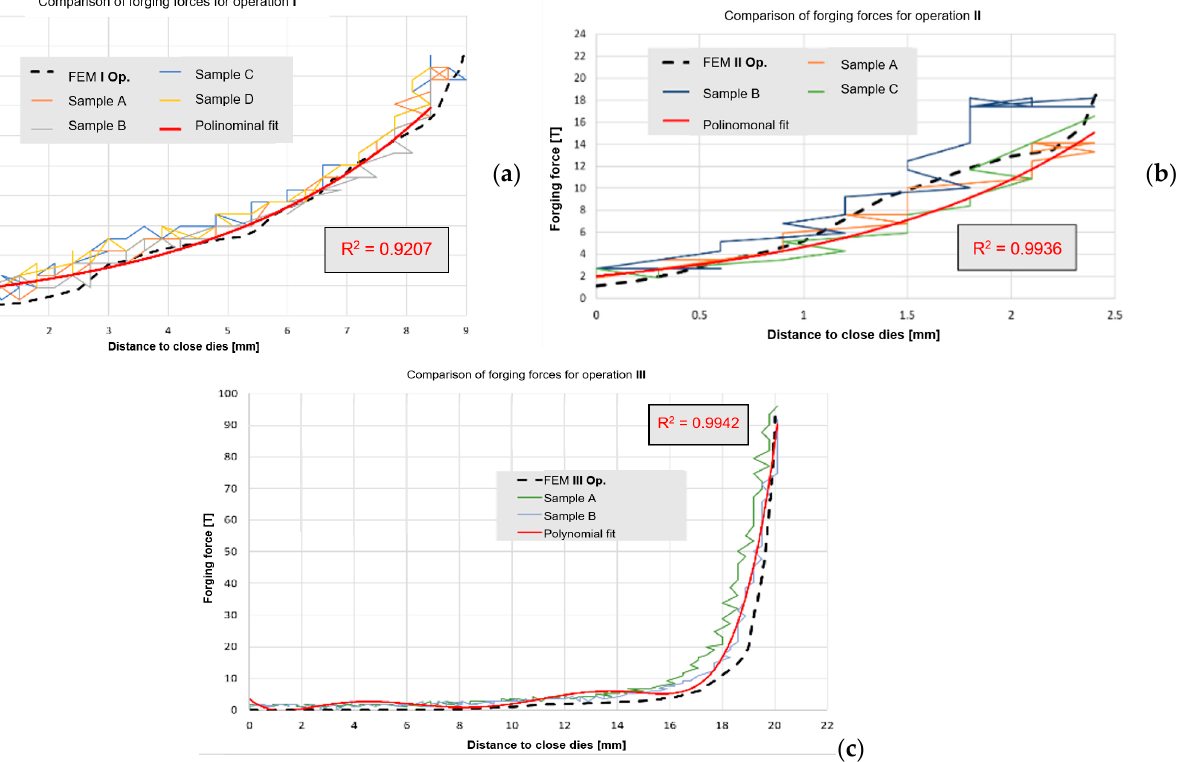
Figure 12. Comparison of the forging forces for each of the 3 operations of physical modeling with the FEM results: ( a ) operation I, ( b ) operation II, ( c ) operation III. the FEM results: ( a ) operation I, ( b ) operation II, ( c ) operation